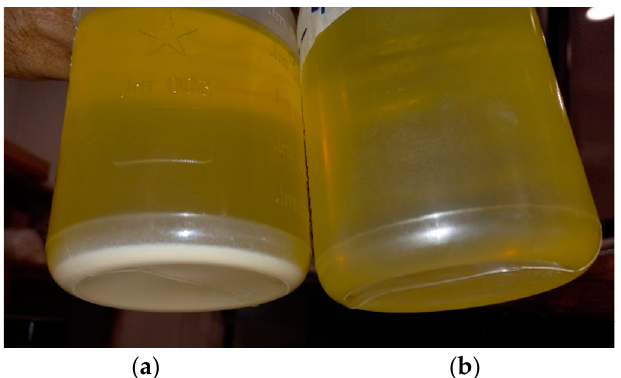
Figure 9. Digital image of stored nanofluids ( a ) NF with untreated SiO2 ( b ) NF with plasma-treated HMDS-coated nanoparticles.